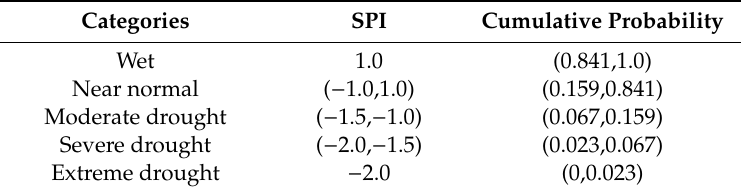
Table 1. Classification of drought and wet conditions based on the Standardized Precipitation Index